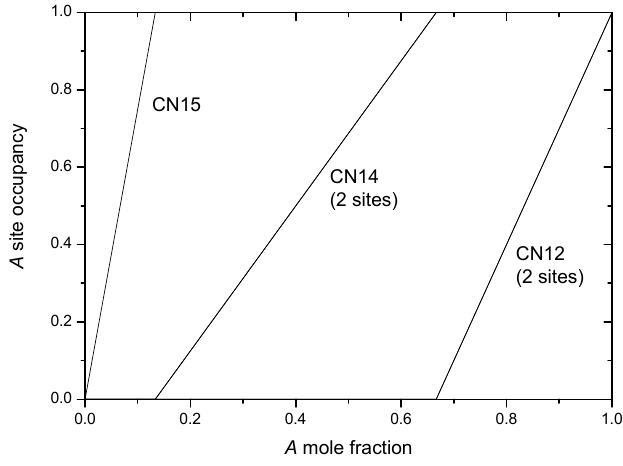
Figure 2. Ideal site occupancies following Kasper rules for the σ phase. As a function of A composition, sites of decreasing CN are occupied sequentially. Sites with equal coordinations are occupied simultaneously. It should be understood that the B atom completes each site to full occupancy when A occupancy is not equal to